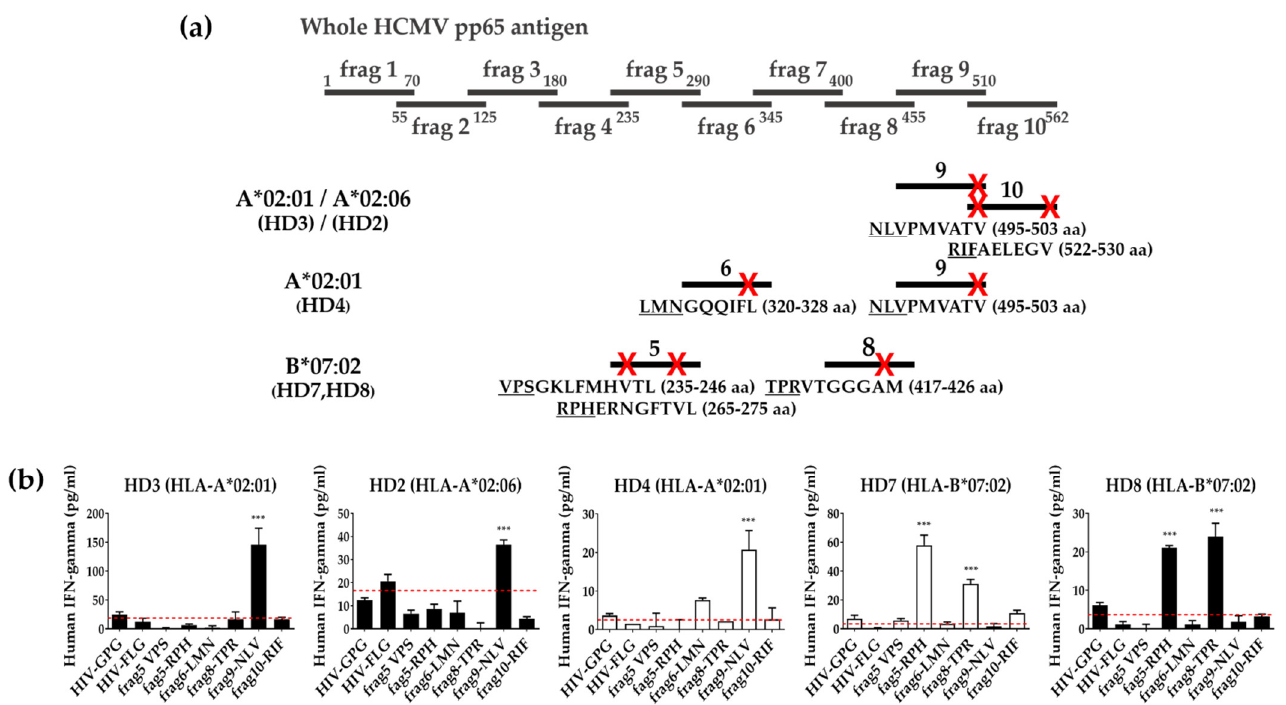
Figure 6. Identification of T cell epitopes within fragment antigens using aAPCs expressing pp65 predicted epitopes. ( a ) Summary of donors, pp65 fragment antigens, and predicted epitopes with T cell response restricted to specific HLA class I allotype. Epitopes with a prediction score of 0.7 or higher in the pp65 positive fragments marked a red X at that region and written below it. ( b ) PBMCs(white bar) or expanded T cells(black bar) of each donor were co-cultured with aAPCs expressing a single HLA class I allotype such as HLA-A*02:01, -A*02:06, or -B*07:02 and mini-genes containing each predicted epitope at a ratio of 10:1 for 24 h and the level of IFN-γ in the culture supernatants was measured by ELISA. HIV epitopes were used as negative controls. HIV-GPG; HLA-B*07:02 restricted epitope within Gag antigen, HIV-FLG; HLA-A*02:01 restricted epitope within Gag antigen. Red dotted line; positive cut-off value. All experiments were performed in triplicate. The mean values ± SD of triplicate. p value was calculated by one-way ANOVA. ***; p < 0.0005.